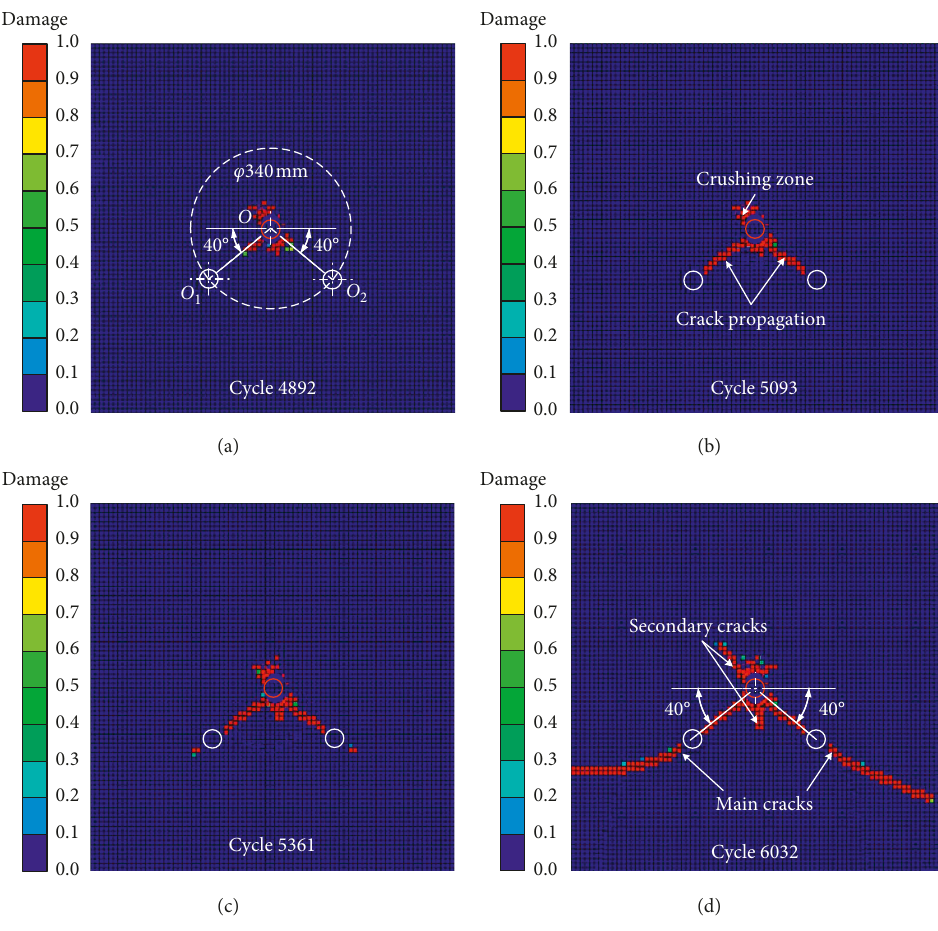
Figure 14: Dynamic rock-breaking process induced by a hydraulic splitter with a 40 ° auxiliary hole: (a) crushing zone formed; (b) crack reaches auxiliary hole; (c) crack crosses auxiliary hole; (d) rock fracture